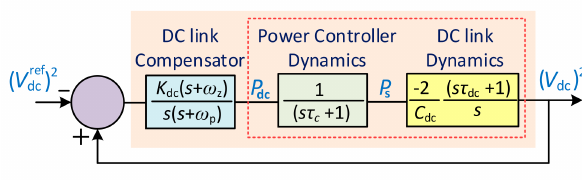
Figure 6. Block diagram of DC-link controller for MSC.